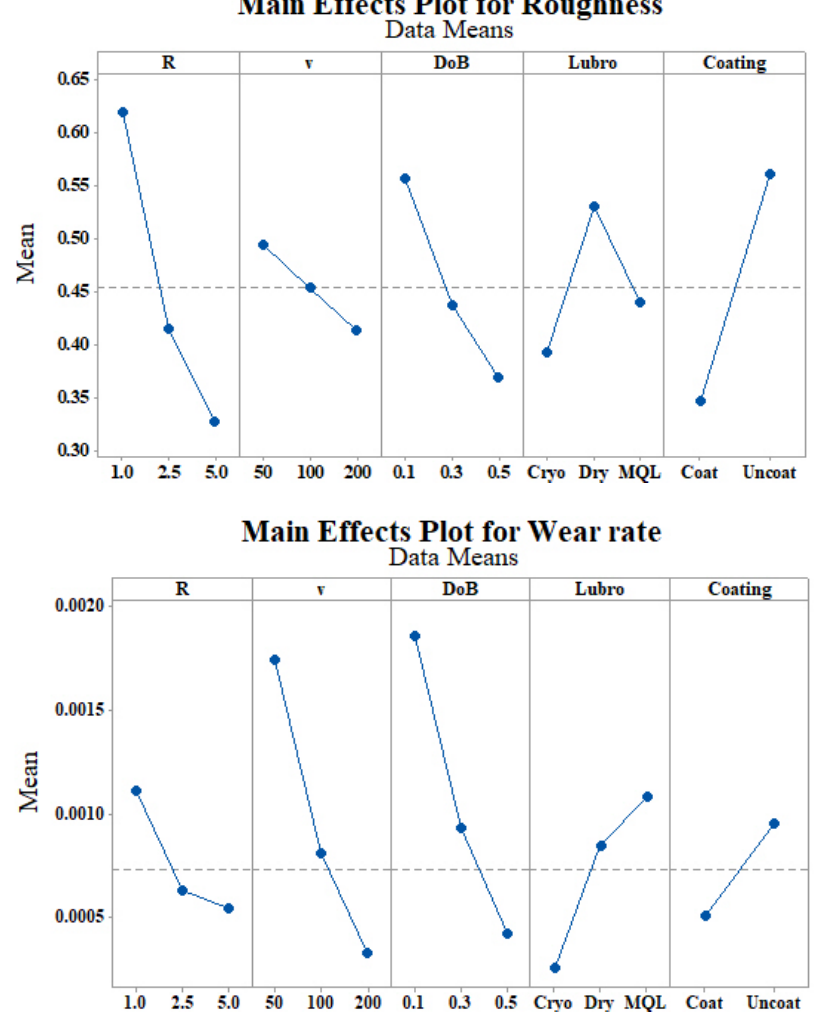
Figure 2. Main effects plot for all the evaluated process inputs and outputs: R (mm), v (m/min), DoB Figure 2. Main e ff ects plot for all the evaluated process inputs and outputs: R (mm), v (m / min), (mm). DoB